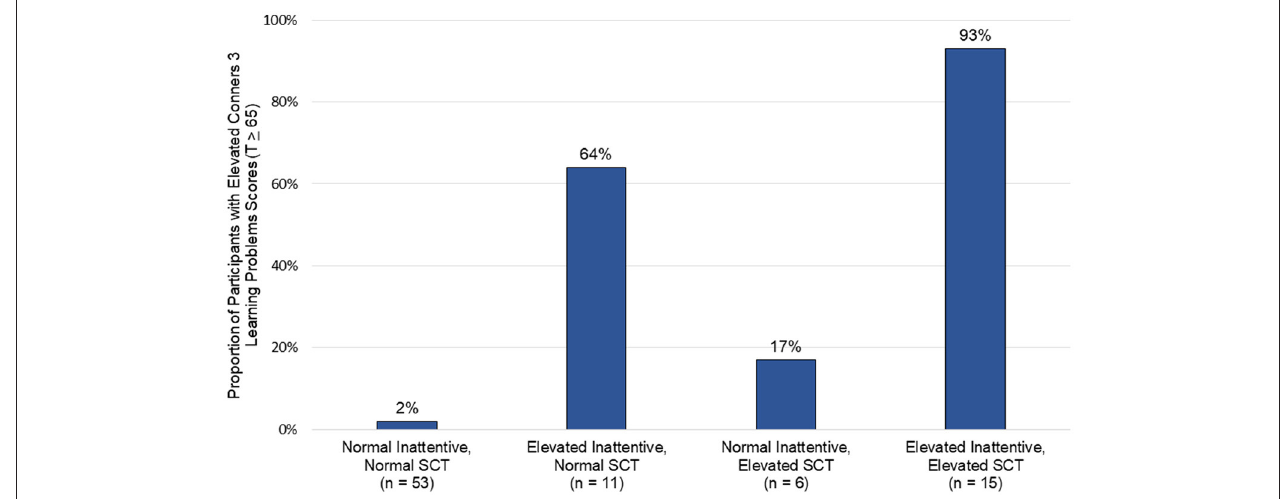
FIGURE 1 | Clusters of inattentive and sluggish cognitive tempo symptoms and their association with learning